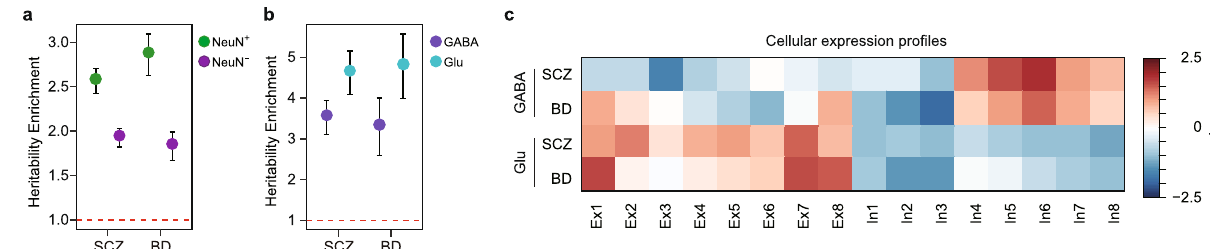
Fig. 5 Comparison of SCZ and BD risk genes. a The SNP-based heritability enrichment of SCZ and BD GWAS in differential NeuN + and NeuN − peaks demonstrates neuronal enrichment (SCZ NeuN + , FDR = 9.33e-24; SCZ NeuN − , FDR = 2.14e-16; BD NeuN + , FDR = 3.94e-15; BD NeuN − , FDR = 6.09e-07). Enrichment ± standard error is depicted. The red broken line indicates heritability enrichment = 1. Source data are provided as a Source Data fi le. b The SNP- based heritability enrichment of SCZ and BD GWAS in differential Glu and GABA peaks suggests that both Glu and GABA neurons are associated with the psychiatric disorders (SCZ GABA, FDR = 4.54e − 9; SCZ Glu, FDR = 3.49e − 10; BD GABA, FDR = 1.10e − 03; BD Glu, FDR = 3.63e − 06). Enrichment ± standard error is depicted. The red broken line indicates heritability enrichment = 1. Source data are provided as a Source Data fi le. c Neuronal subtype expression pro fi les of SCZ and BD risk genes detected by GABA and Glu